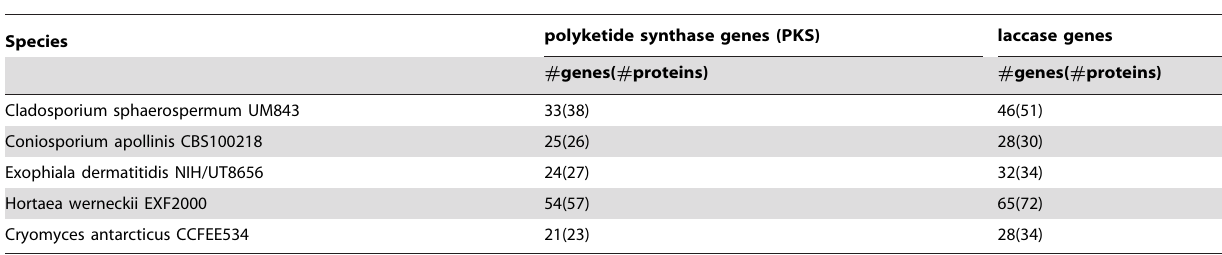
Table 4. Laccase and polyketide synthase